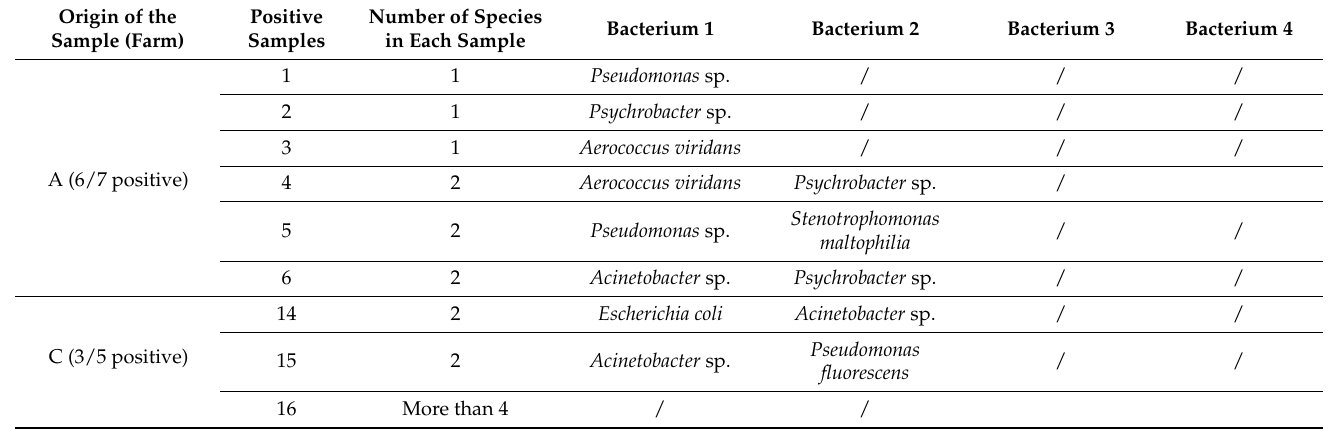
Table 1. Bacteria species and bacteria isolates identified in each positive sample (19/76 positive samples and 2/76 contaminated samples), no bacterium was identified in non-displayed samples (55/76) in the